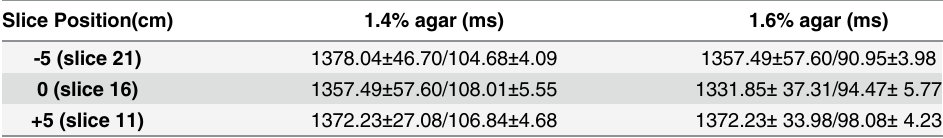
Table 1. Mean T 1 /T 2 values measured at three different slice positions from the two adjacent wedge compartments containing 1.4% and 1.6% agar. Slice